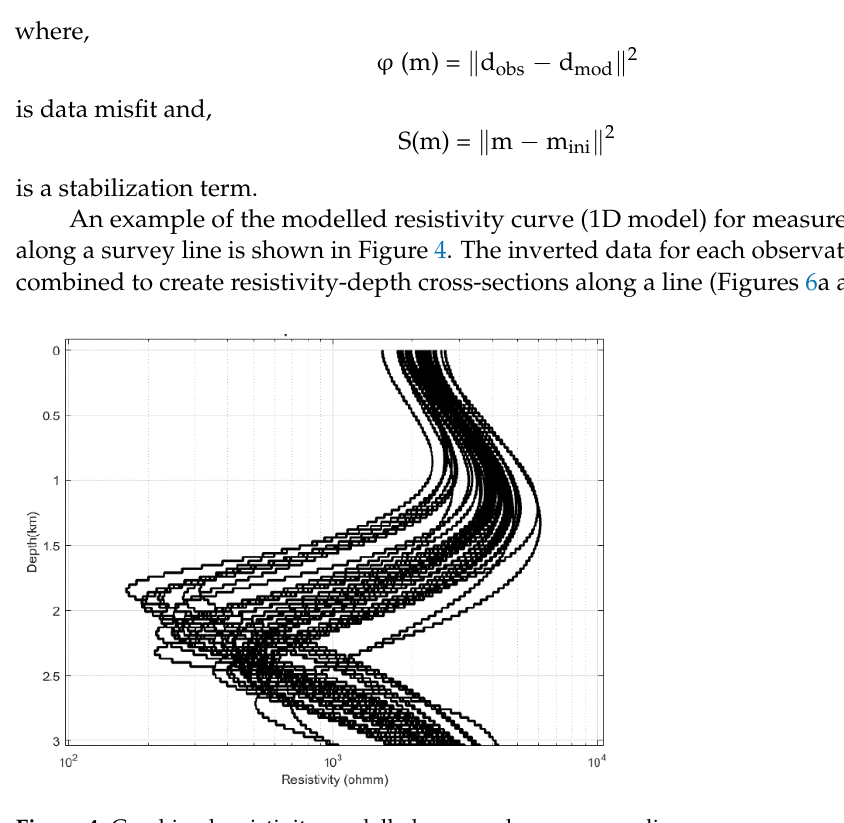
Figure 4. Combined resistivity modelled curves along a survey line.